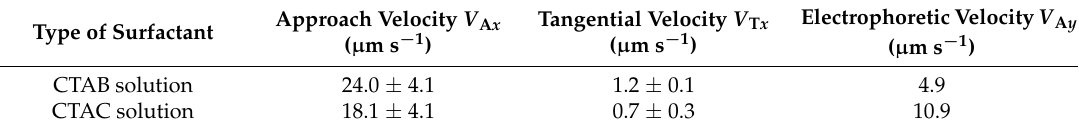
Figure 7. Velocity components of a particle near an electrode in a laminar flow cell. Table 1. Components of particle velocities near the electrode in CTAB or CTAC solution.